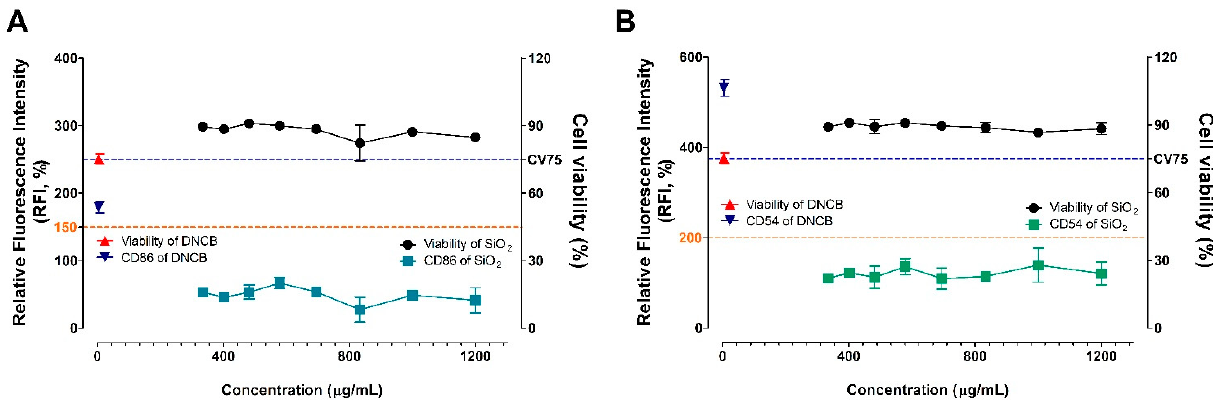
Figure 4. Evaluation of ( A ) CD86 and ( B ) CD54 expression, and cell viability in the h-CLAT assay. The cells were treated with the silica NP, and positive control (DNCB, CAS number 97-00-7). Data are expressed as mean ± SEM ( n = 6). Positive control was tested in parallel (4 μ g/mL). DNCB = 2,4-dinitrochlorobenzene.